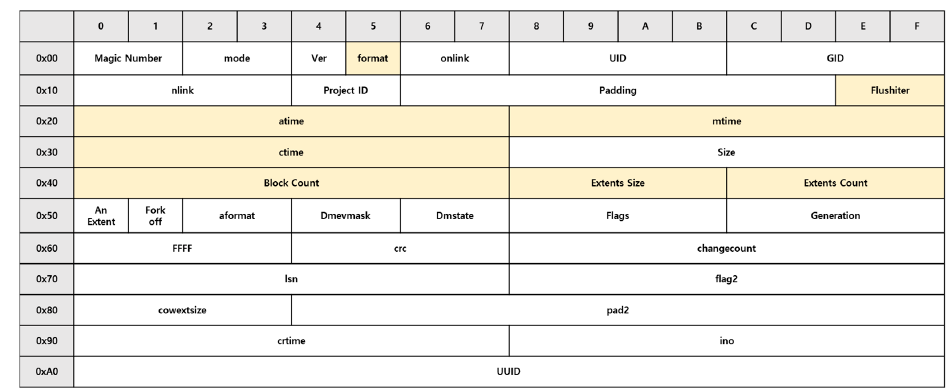
Figure 7. Inode core structure of XFS file system.